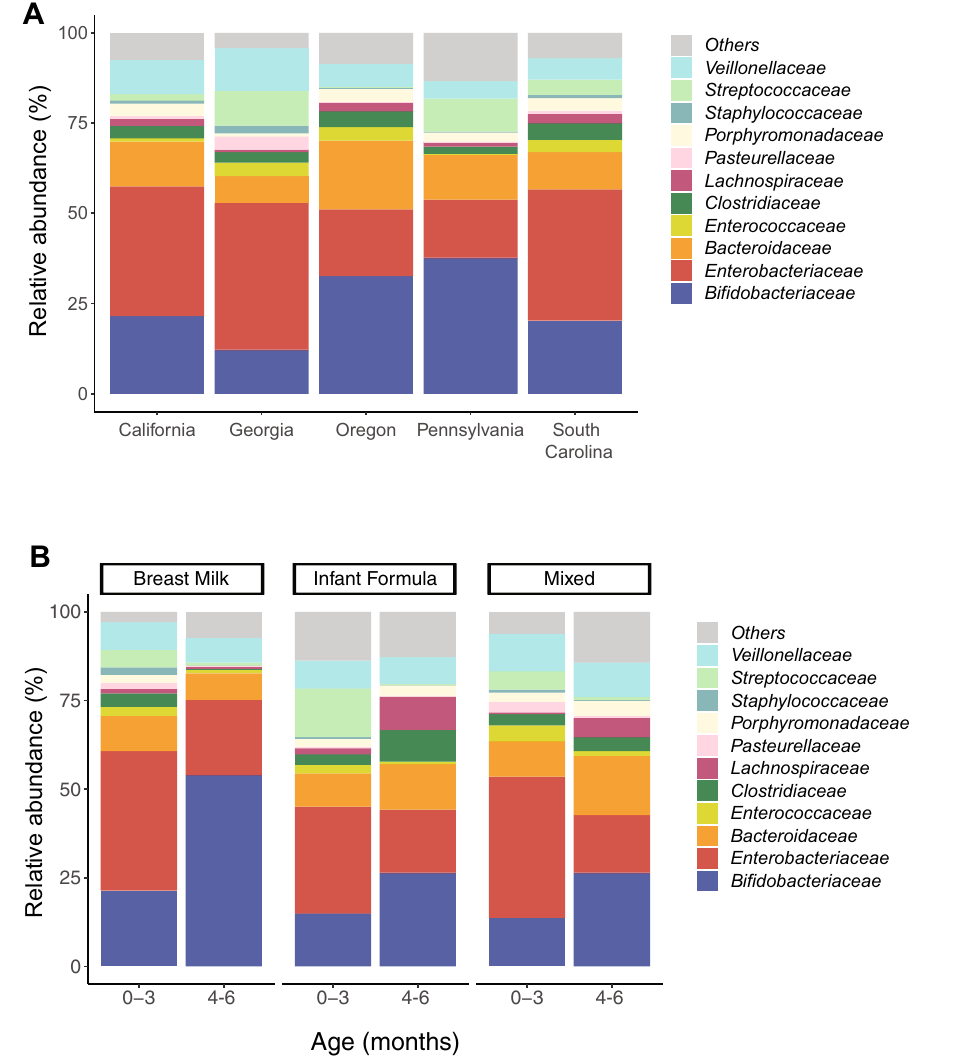
Figure 1. Relative abundance of bacterial families by location, diet and age. ( A ) Relative abundance (%) of top bacterial families identified in infants 0–6 months of age across five US states. ( B ) Relative abundance (%) of top bacterial families identified and grouped by age and